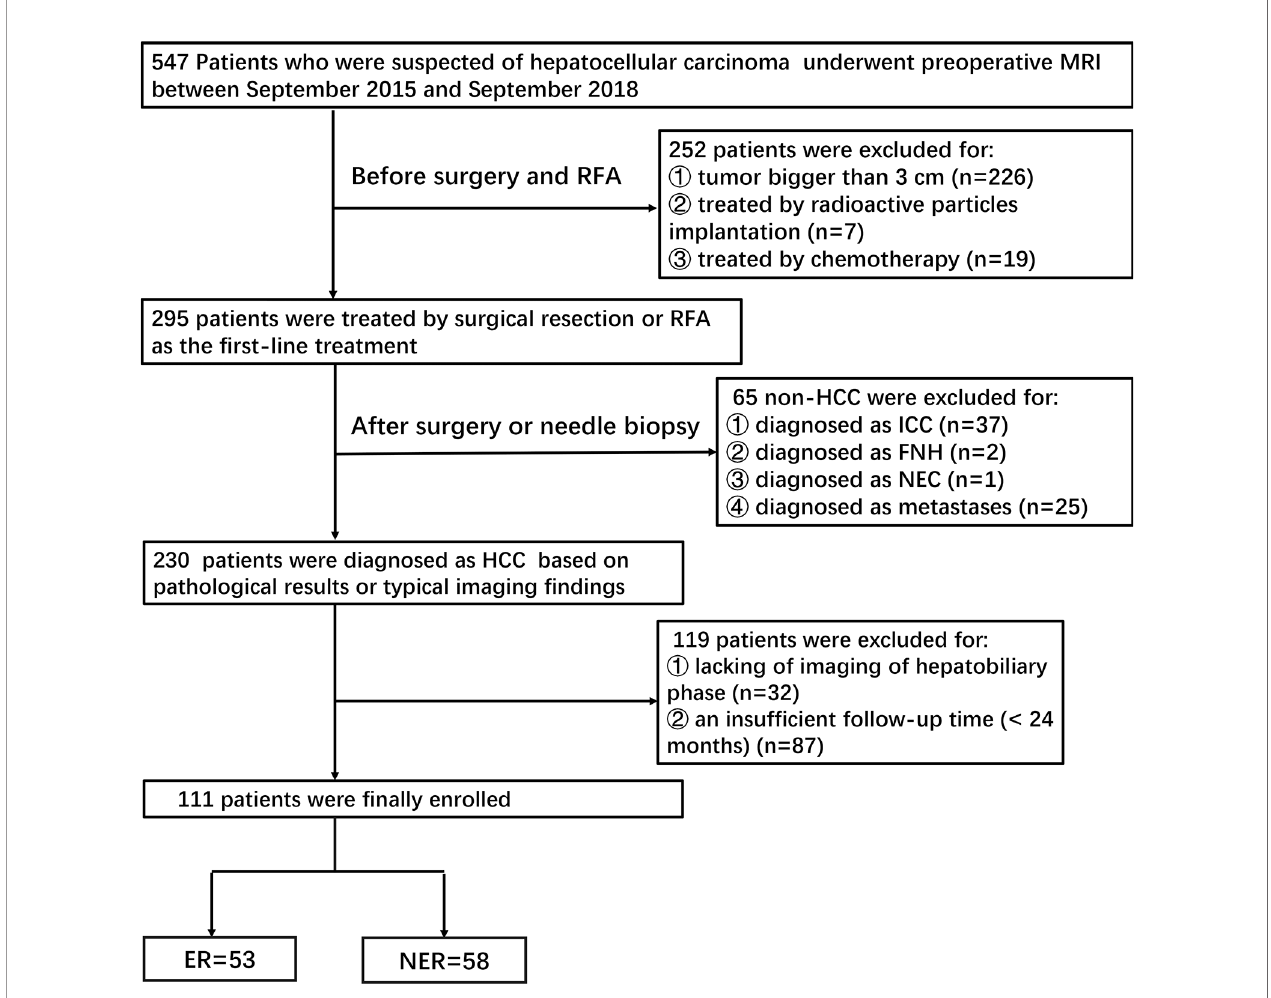
FIGURE 1 | Flowchart showing the inclusion and exclusion of